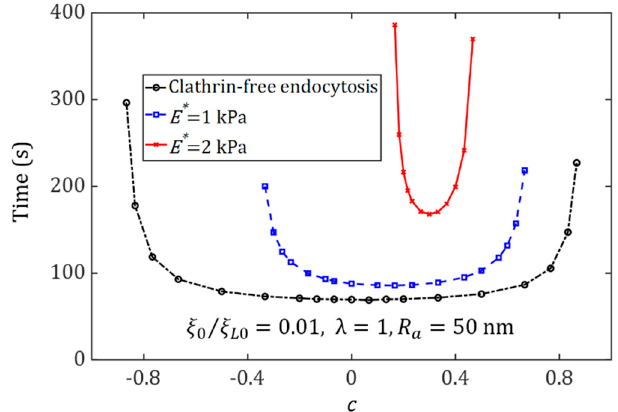
Figure 4. Wrapping time as a function of the degree of non-uniformity of ligand distribution, c , for membrane-mediated endocytosis and cytoskeleton-associated endocytosis pathways with E ∗ = 1 kPa, E ∗ = 2 kPa, during the cellular uptake of spherical NPs ( R a = 50 nm, λ = 1) with ξ 0 = 0.01 ξ L 0